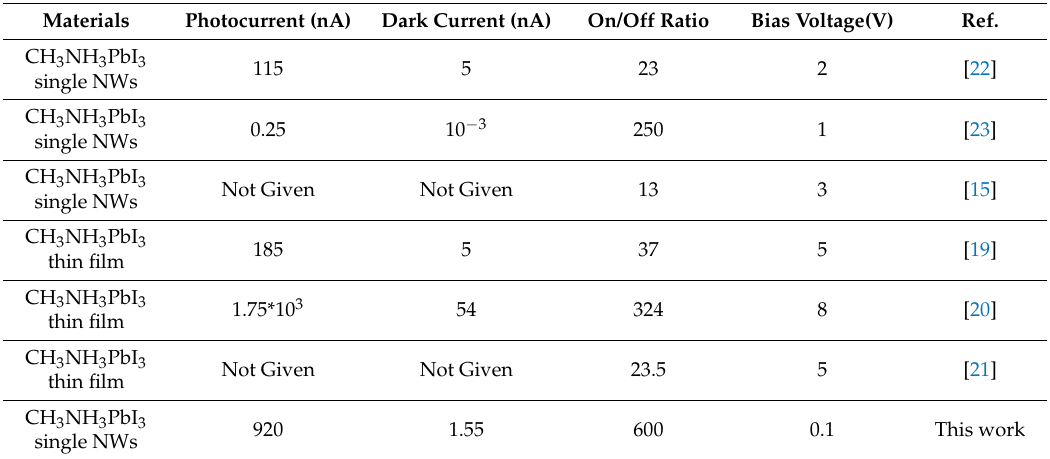
Table 1. Device performance comparison between this work and other MAPbI3-based photodetectors. Materials Photocurrent